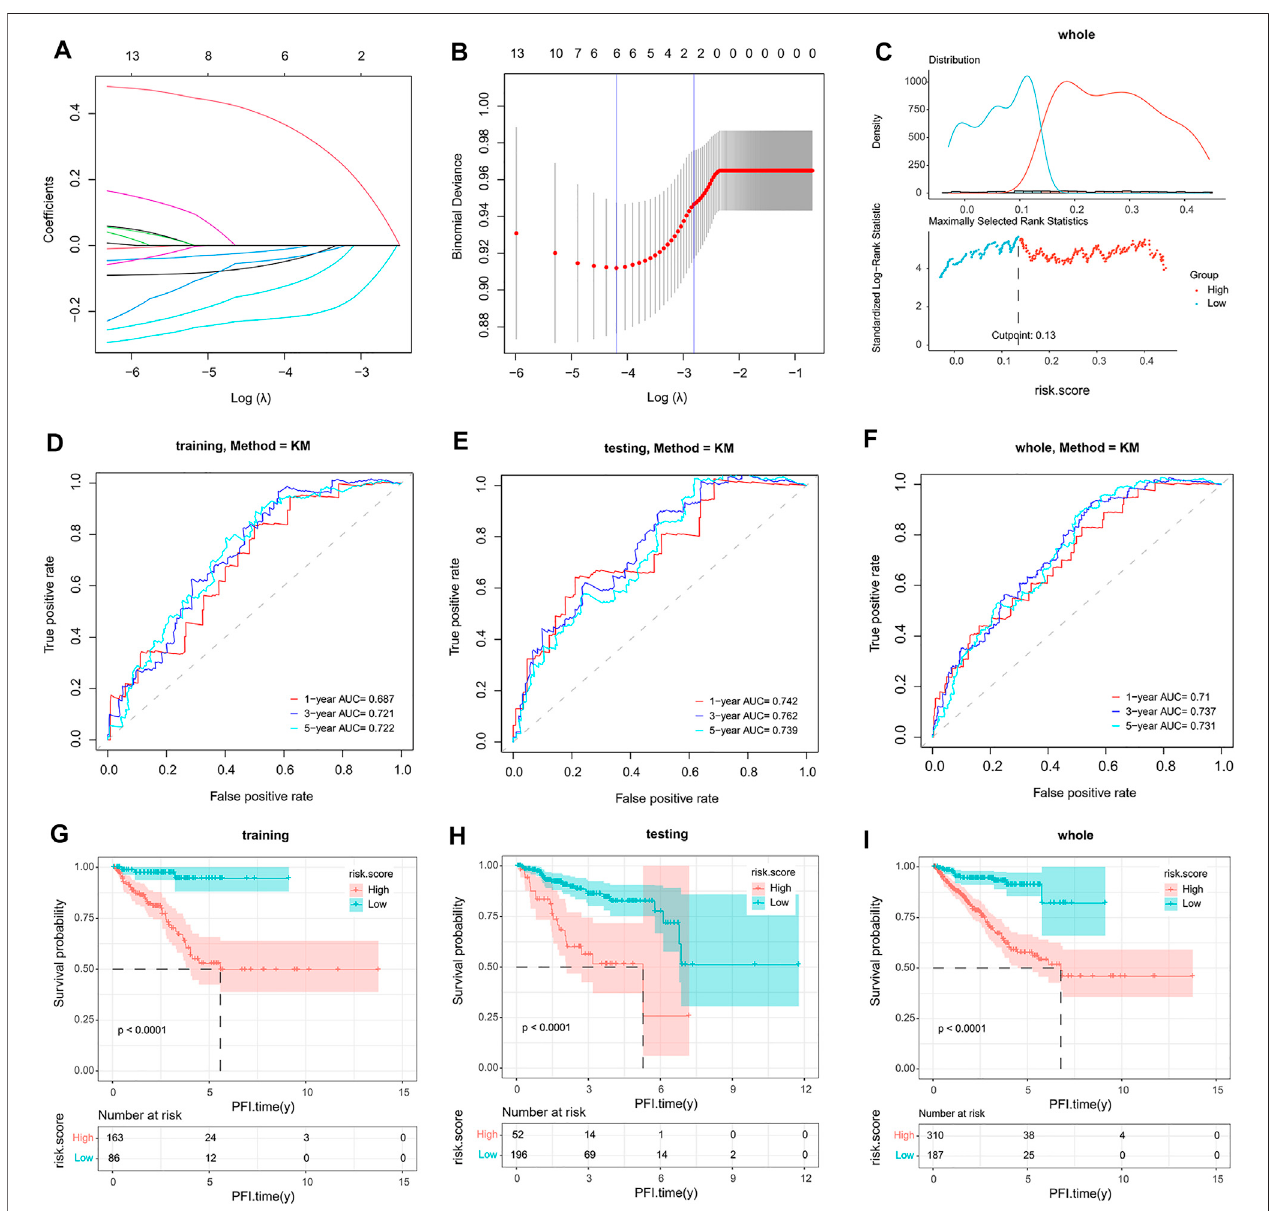
FIGURE 9 | Construction and validation of a two-gene signature. (A,B) Identi fi cation of two genes and their coef fi cients in the optimal prognostic model by lasso- penalized Cox regression analysis. (C) Determination of the optimal cutoff value in the whole dataset. (D – F) The predictive capacity of the model veri fi ed by the ROC analysis in the training, testing, and whole dataset. (G – I) . Kaplan – Meier survival analysis of patients with a high-risk and low-risk score in the training, testing, and whole